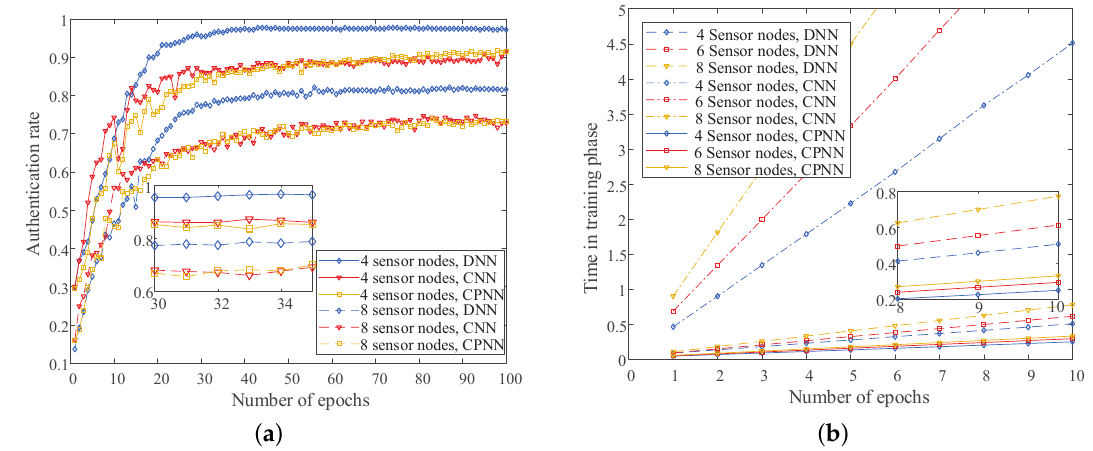
Figure 7. The authentication performance with different algorithms. ( a ) The authentication rate of different algorithms under different numbers of sensor nodes; ( b ) The time in the training phase of different algorithms under different numbers of sensor nodes.